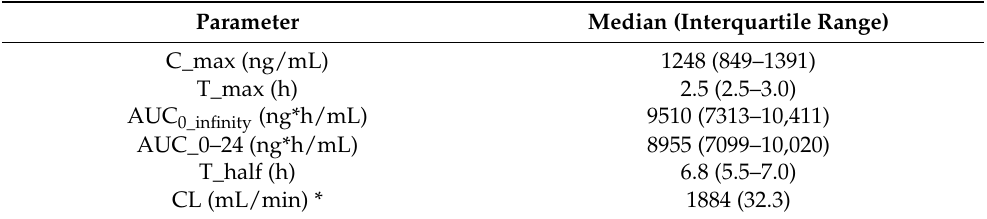
Table 3. Non-compartmental pharmacokinetic parameters after single-dose administration of met- formin 1000 mg ( n = 17).